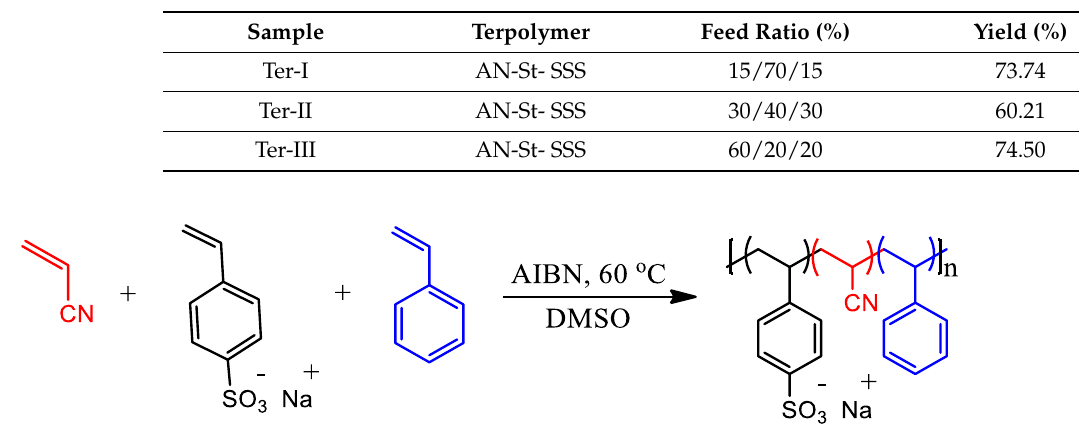
Table 1. Polymerization results of terpolymers Ter-I, Ter-II, and Ter-III.